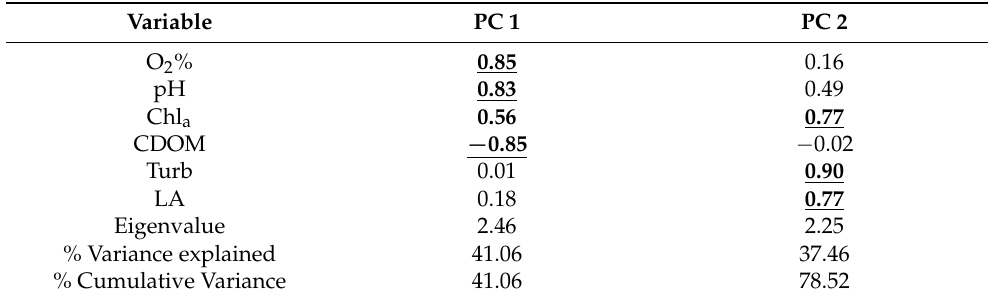
Table 4. Loadings of BIOFISH parameters on varimax-rotated PCs. Moderate loadings (0.5–0.75) are bold; strong loadings (>0.75) are bold and underlined.